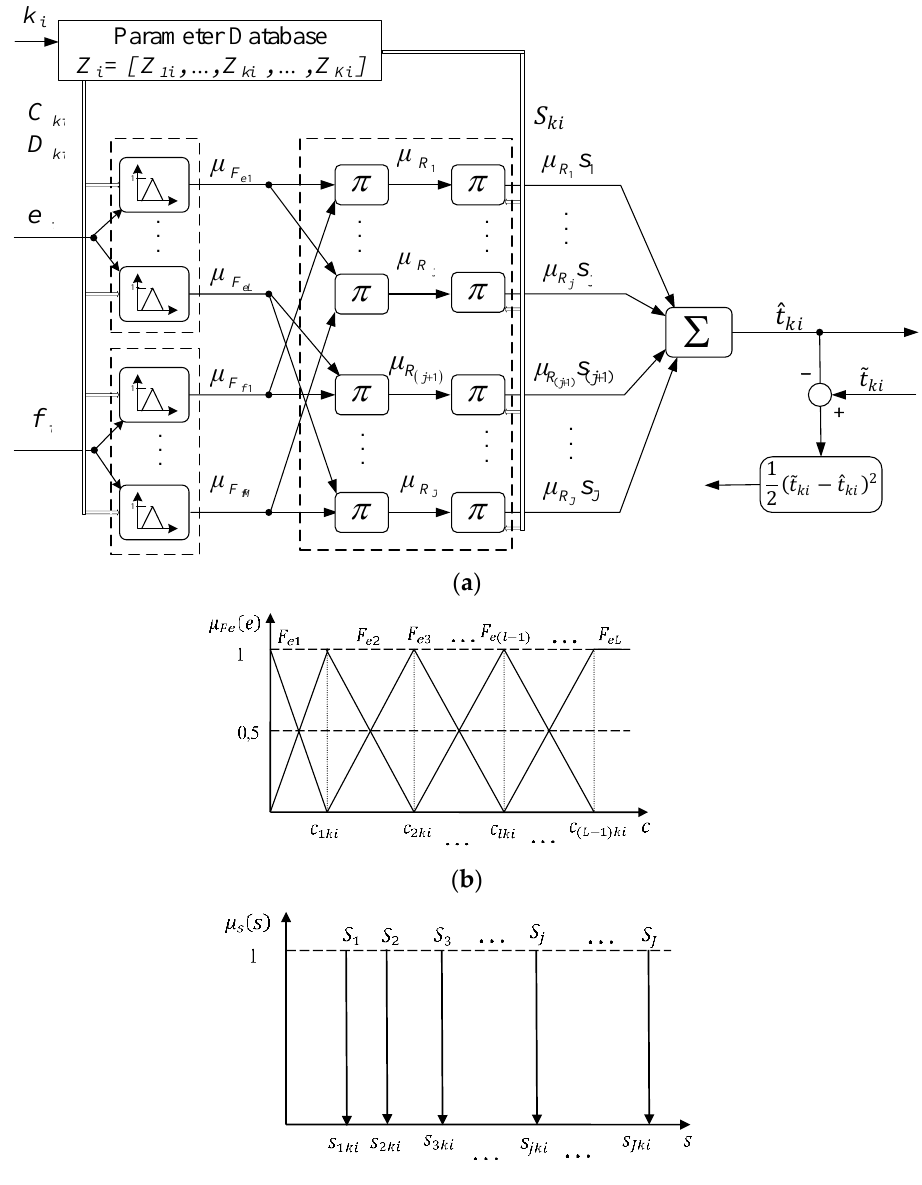
Figure 3. Neuro-fuzzy model: ( a ) overall view, ( b ) input fuzzy set functions, and ( c ) output fuzzy sets functions.